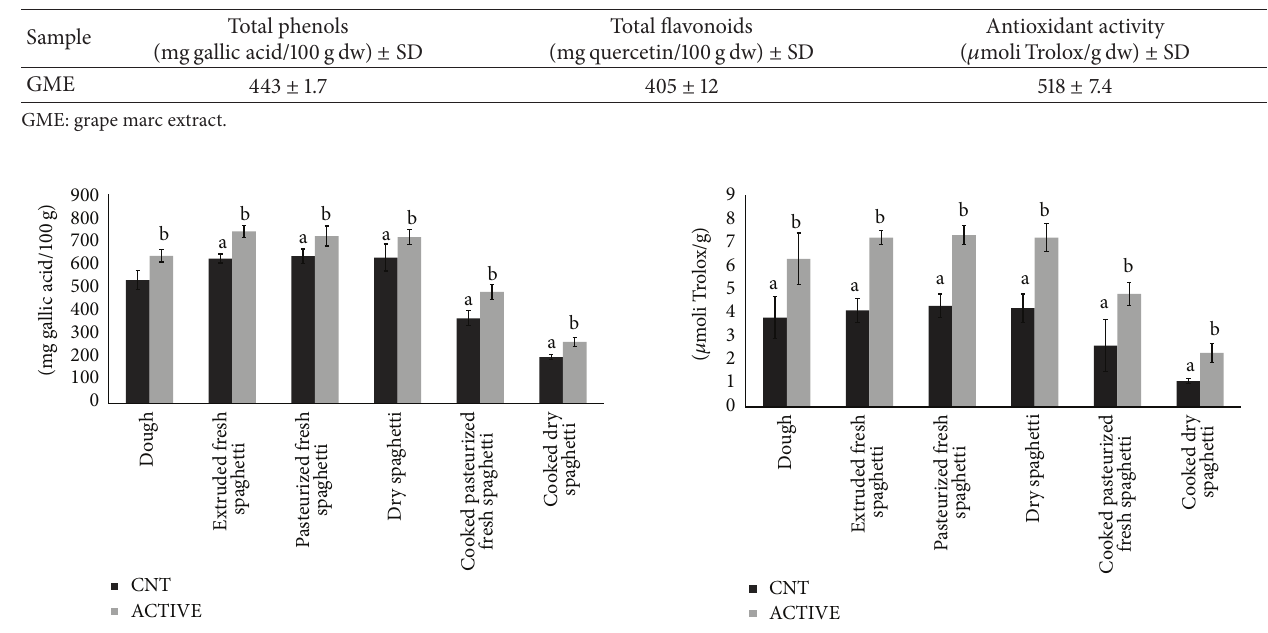
Figure 2: Antioxidant activity of spaghetti samples in each step of the production process. Results are expressed as means ± SD for 𝑛 = 3 . a , b Data in columns with different superscripts are significantly different ( 𝑃 < 0.05 ). CNT: samples without the addition of grape marc extract; ACTIVE: samples with the addition of grape marc